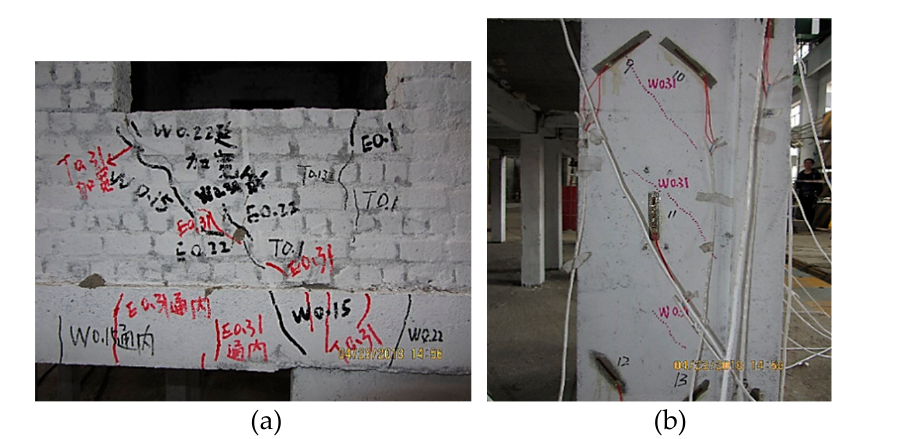
The new cracks appeared close to the location of the window bottom (a). The previous cracks propagated and cracked all the way through (b).